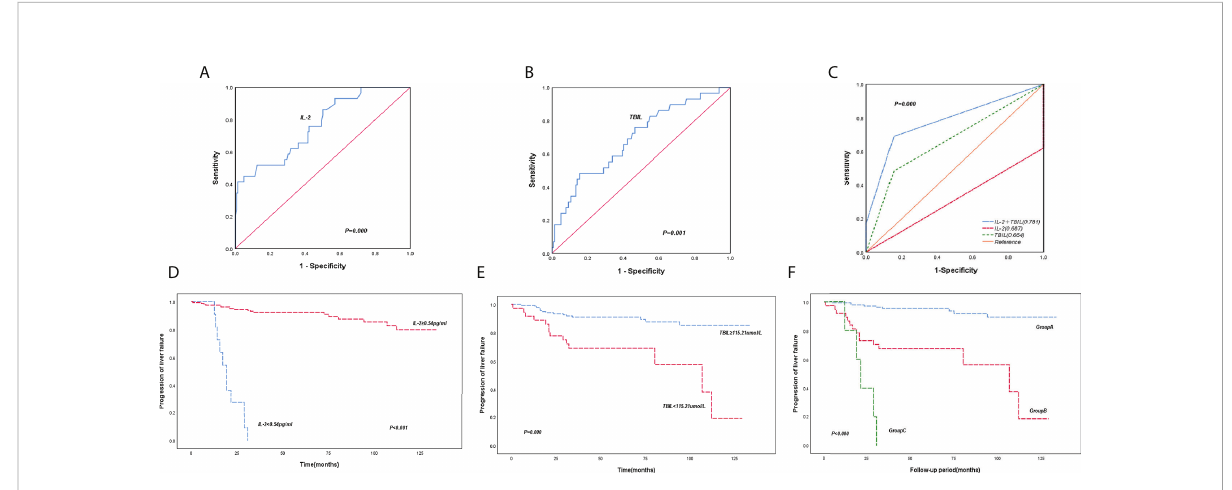
FIGURE 2 ROC curve and Kaplan-Meier survival curve of IL-2 combined with TBIL. (A) ROC curves for IL-2. (B) ROC curves for TBIL. (C) ROC curve of IL-2 combined with TBIL. (D, E) Cumulative survival of PBC patients were analyzed by the Kaplan-Meier method, using the baseline IL-2 and TBIL levels. (F) Subgroup studies were strati fi ed for the incidence of liver failure in patients by the Kaplan-Meier method based on the levels of baseline IL-2 and